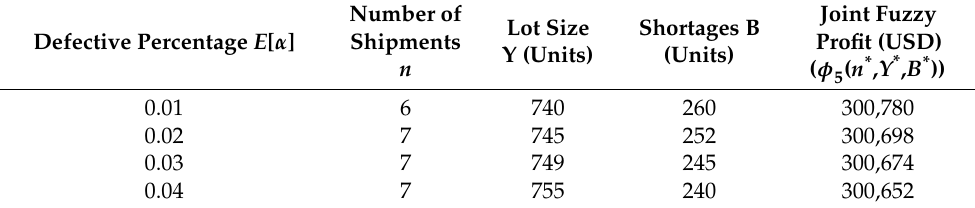
Table 6. Impacts of the defective percentage parameters on the decision variables and joint fuzzy profit.